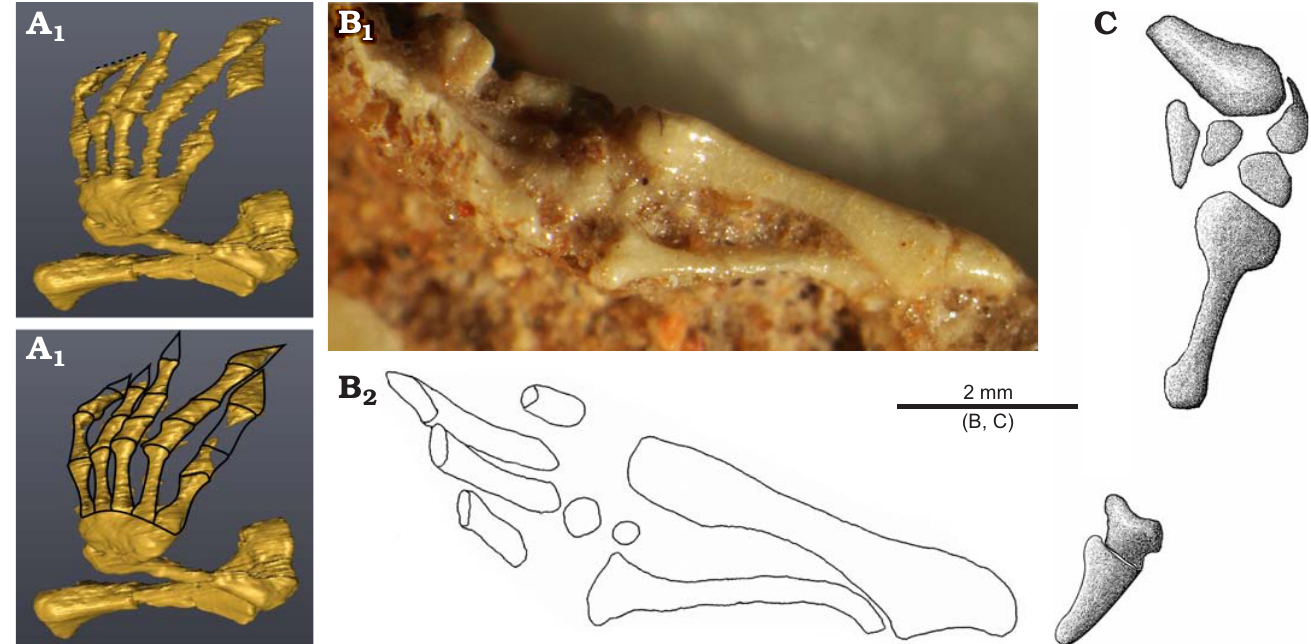
Fig. 7. Forelimb (with details of manus) of the stem-amphisbaenid Slavoia darevskii Sulimski, 1984 from late Campanian of Mongolia. A . ZPAL MgR-III/79, CT-scans. The dotted line in A 1 marks surface where the digit I and II are eroded; outlines in A 2 mark phalanges and metacarpals (pre- served and reconstructed). B . ZPAL MgR-I/9; photograph (B 1 ), outlines of the forearm and partially preserved hand (B 2 ). C . ZPAL MgR-I/8, partially preserved hand.